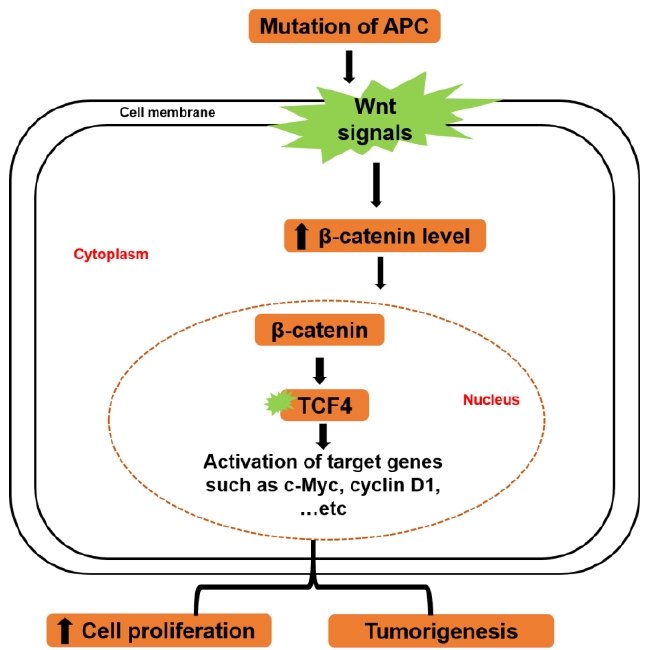
Figure 3. Regulation of Wnt / β -catenin / c-Myc signaling pathway. Mutation of adenomatous polyposis coli (APC) triggers Wnt signaling, which in turn increases the cytoplasmic level of free β -catenin migrating to the nucleus. In the nucleus, β -catenin activates transcriptional genes such as c-Myc and cyclin D1 through activation of transcription factor (TCF)4, which leads to the promotion of cell proliferation and tumorigenesis.